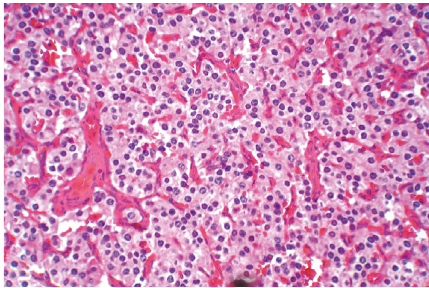
Figure 3: Pancreatic endocrine tumor with nests of uniform cells surrounded by a fibrovascular stroma.